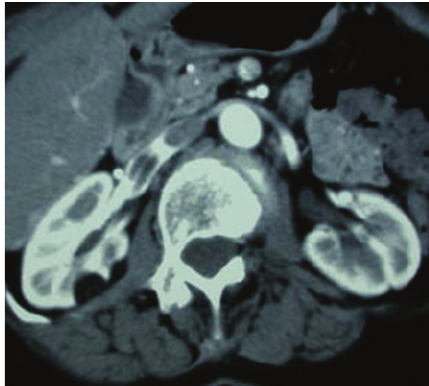
Figure 2: Axial contrast enhanced abdominal CT showing an IVC and renal thrombus with attenuation value—70